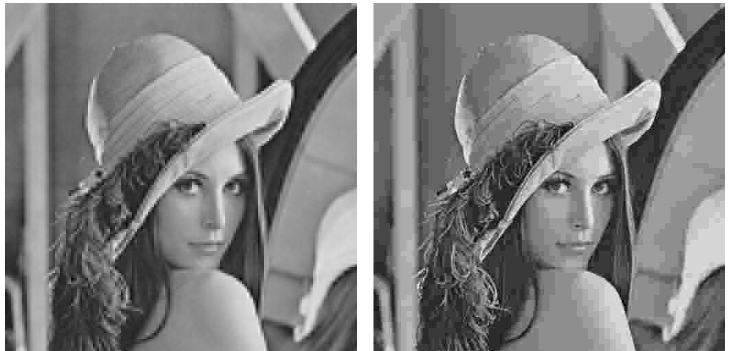
Figure 7. Output images. Left hand side : Lena, analog transmission, 0.80 SSIM. Right hand side : Lena, JPEG encoding, 0.78